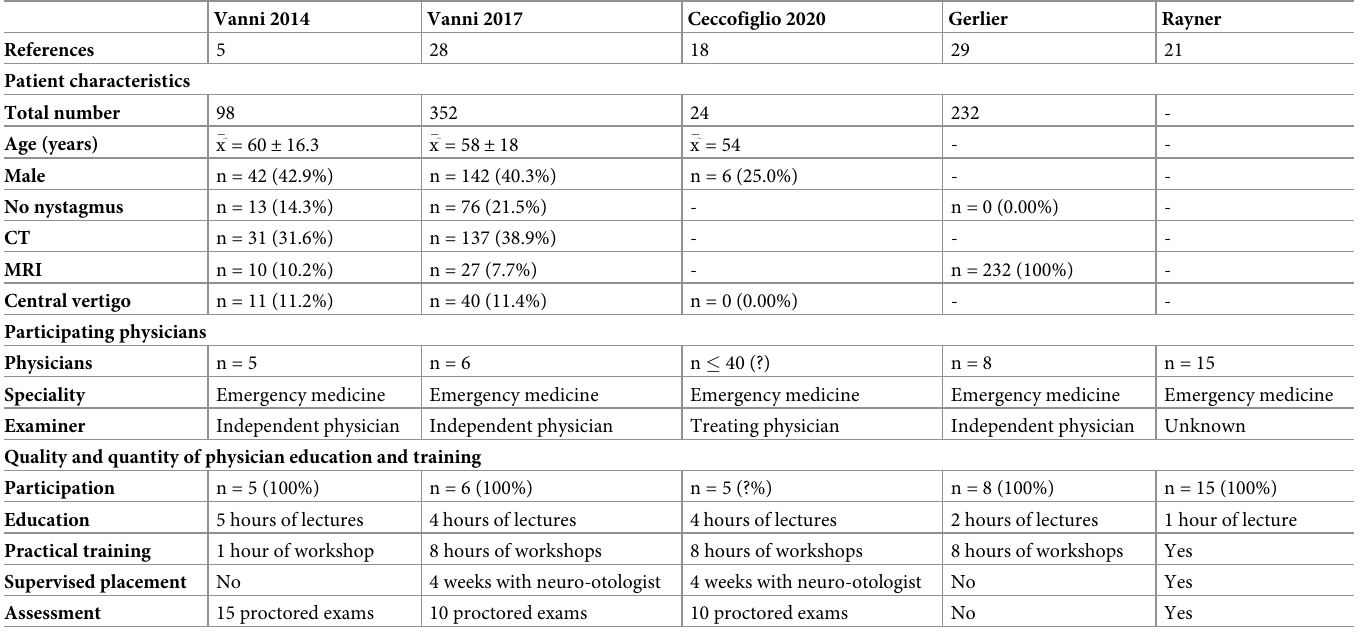
Table 1. Patient and physician characteristics in the studies included in the qualitative synthesis.